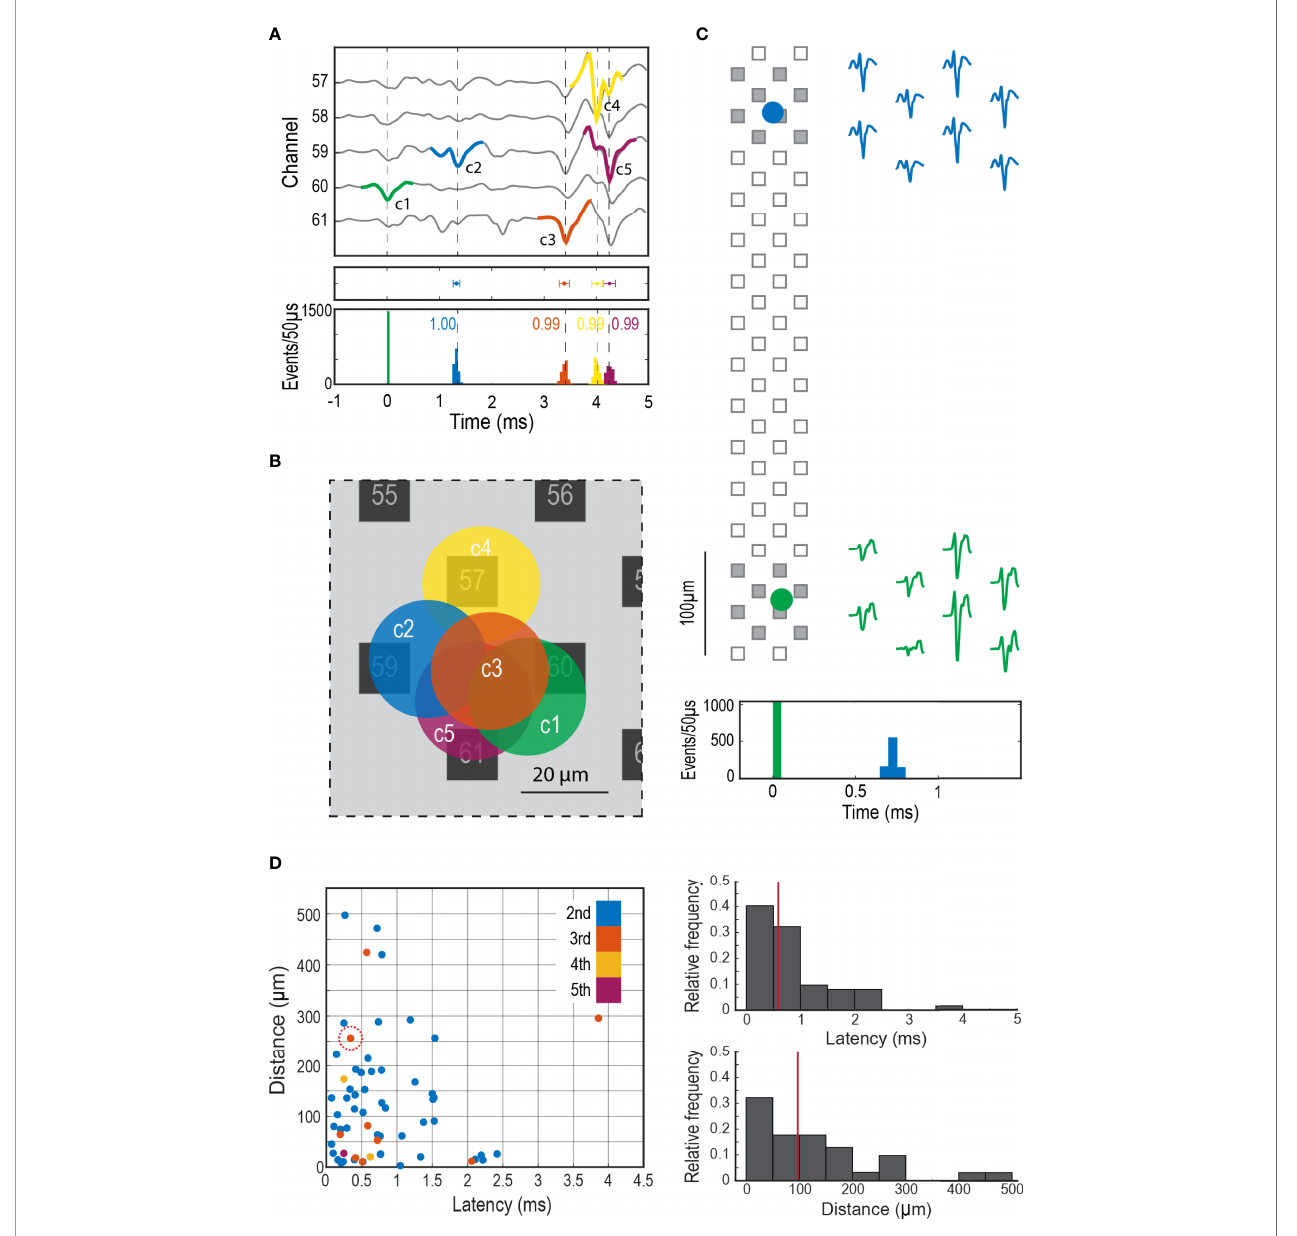
FIGURE 4 | Synchronized fi ring in the adrenal medulla. (A) Firing sequence of a group of clustered cells, Top panel shows an extended template of the fi rst unit (c1 in green) displaying the fi ring sequence of the later units (c2 to c5, blue, orange, yellow and purple), middle panel shows the mean latency ± SD (mean ± 2SD, c2 = 1.33 ± 0.06 ms, c3 = 3.39 ± 0.10 ms, c4 = 4.01 ± 0.10 ms and c5 = 4.26 ± 0.11 ms) in reference to c1, bottom panel shows the histograms in 50 µs bins of the fi ring distribution between the fi rst cell and the subsequent cells in the network. (B) Shows the approximate location of the synchronized cells in A, the circles represent a 20 µm in diameter cell. (C) Firing synchronization between two distant cells, the circles represent the theoretical location of each cell over the probe, the fi lled squares correspond to the recording sites shown in the 2 ms templates on the right. The histogram at the bottom shows the fi ring distribution in 50 µs bins of the second cell (blue) in relationship to the fi rst cell (green). (D) Left panel shows the relationship between latency and distance in coupled cells. The different colors indicate the order of appearance of each cellular component in the fi ring sequence. The abscissa for each dot is the latency from the previous action potential in the sequence; the ordinate is the distance between the calculated positions for the two cells. For example, the circled dot represents the 3 rd component of a fi ring sequence. In this case this cell fi red approximately 0.4 ms after the second cell in that sequence and the calculated distance between this cell and its predecessor in the sequence was ~250 µm. The most frequent sequence had action potentials from only two cells (blue dots). Top right histogram shows the relative frequency distribution of the latency between consecutive cell pairs (n=62, the color code matches previous panels), bottom right histogram shows the relative frequency of the distance between cell pairs. The red vertical lines mark the median, 0.59 ms for latency and 97 µm for